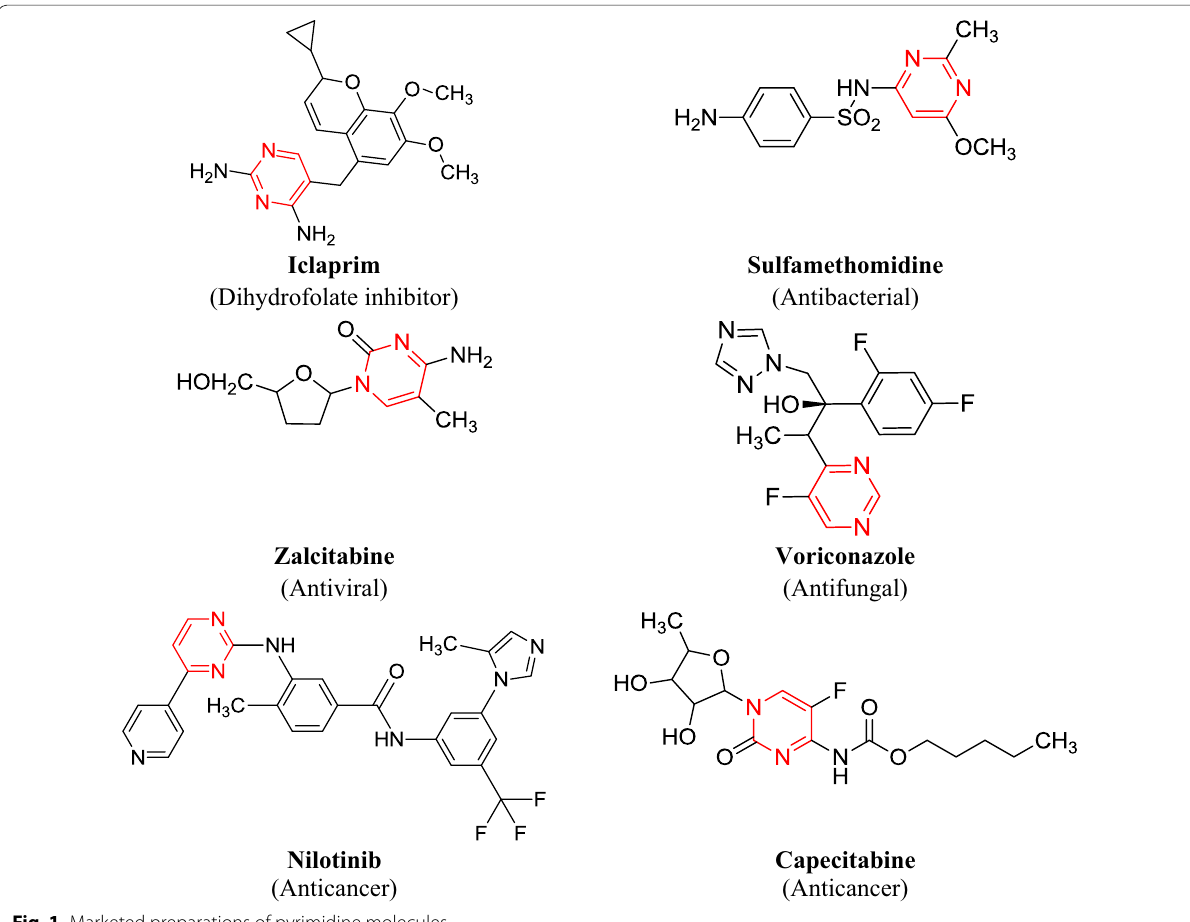
Fig. 1 Marketed preparations of pyrimidine